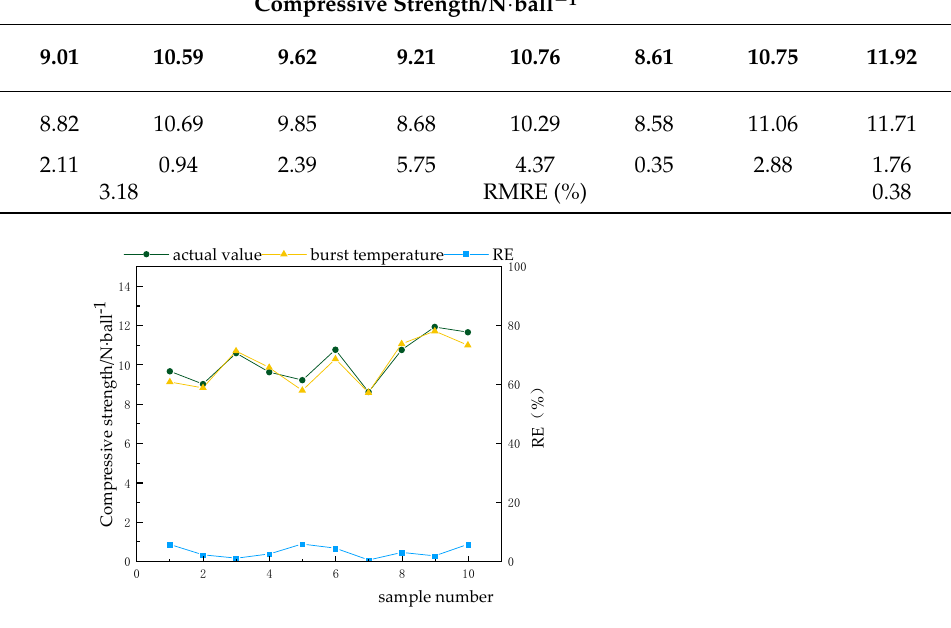
Figure 8. Variation trend of errors of compressive strength prediction model.